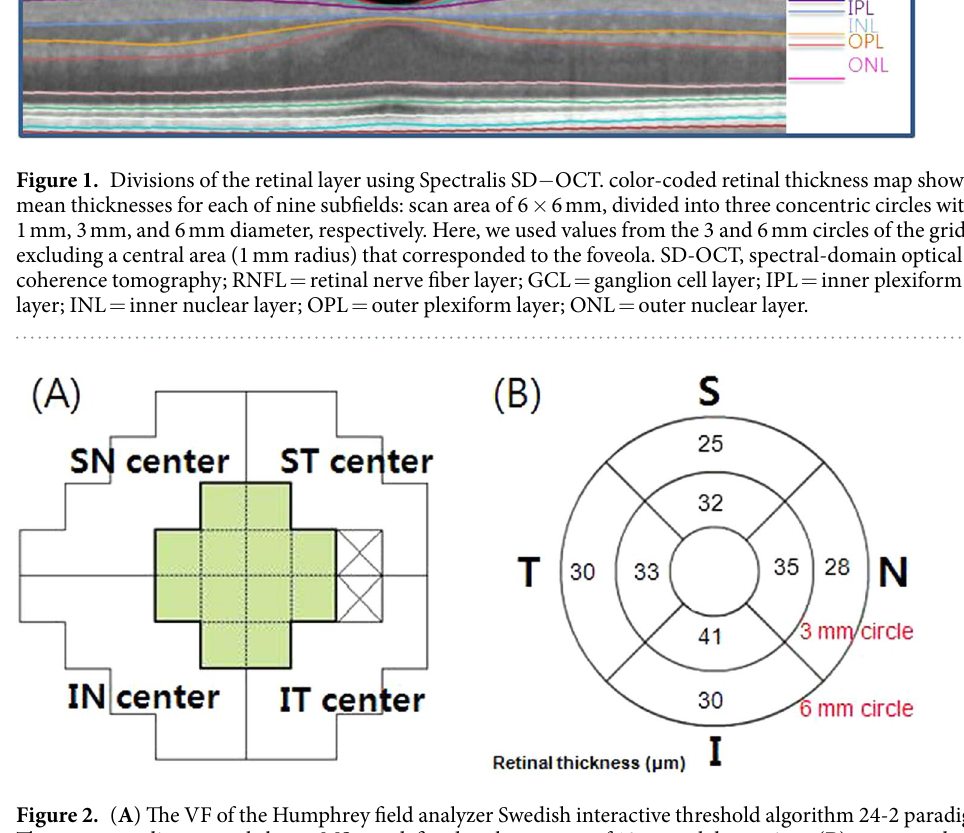
Figure 2. ( A ) The VF of the Humphrey field analyzer Swedish interactive threshold algorithm 24-2 paradigm. The corresponding central cluster MS was defined as the average of 12 central data points. ( B ) segmented retinal layer thickness measurement by Spectralis HD-OCT (scan area of 6 × 6 mm, macular area) of a right eye. S = superior; ST = superotemporal; SN = superonasal; I = inferior; IT = inferotemporal; IN =